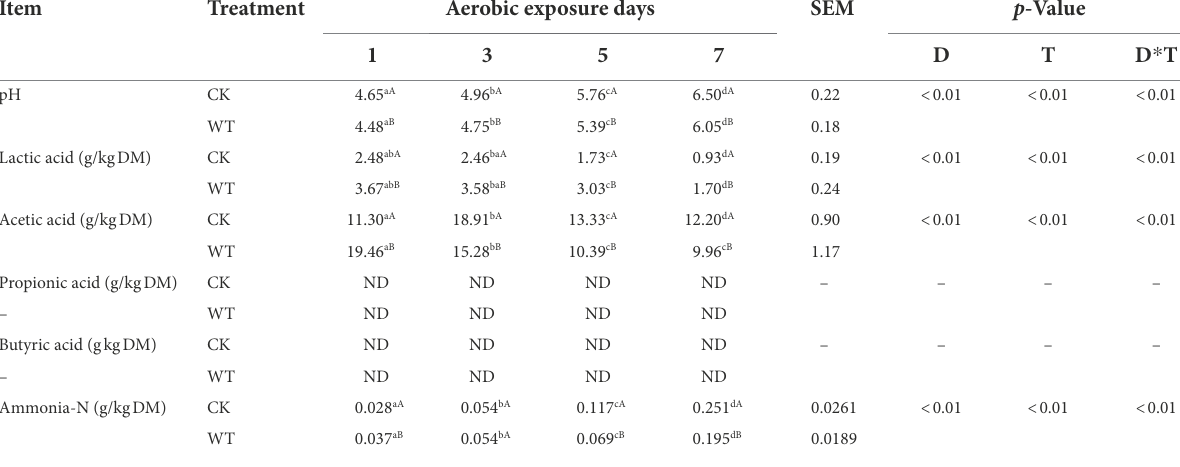
TABLE 2 Fermentation characteristics of king grass silage after aerobic